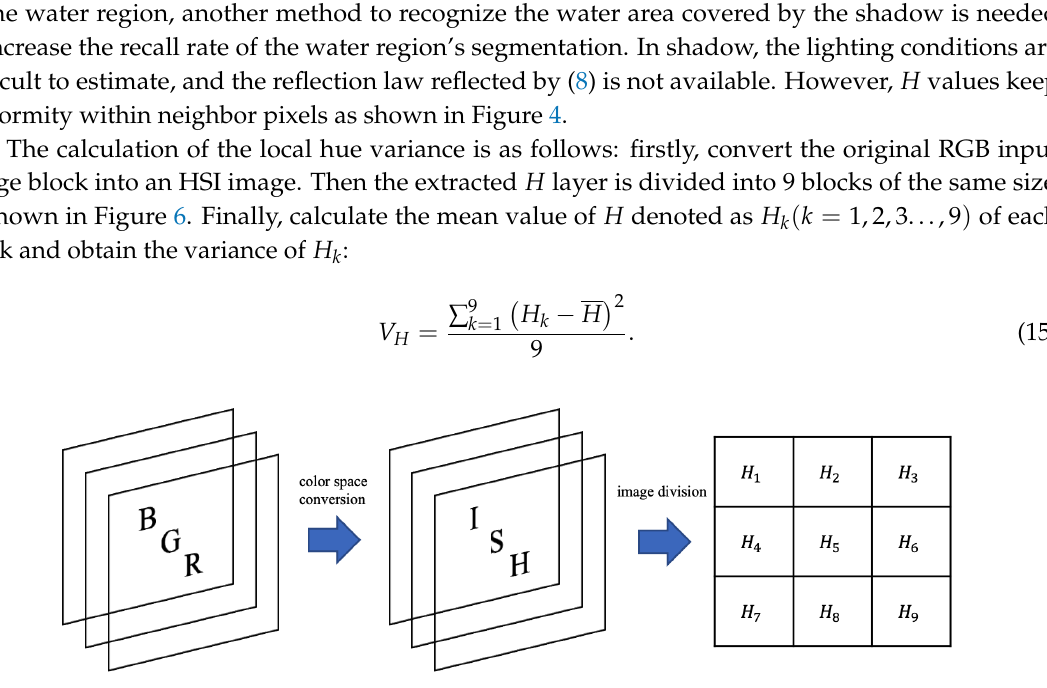
Figure 6. Color space conversion and image division for local hue variance